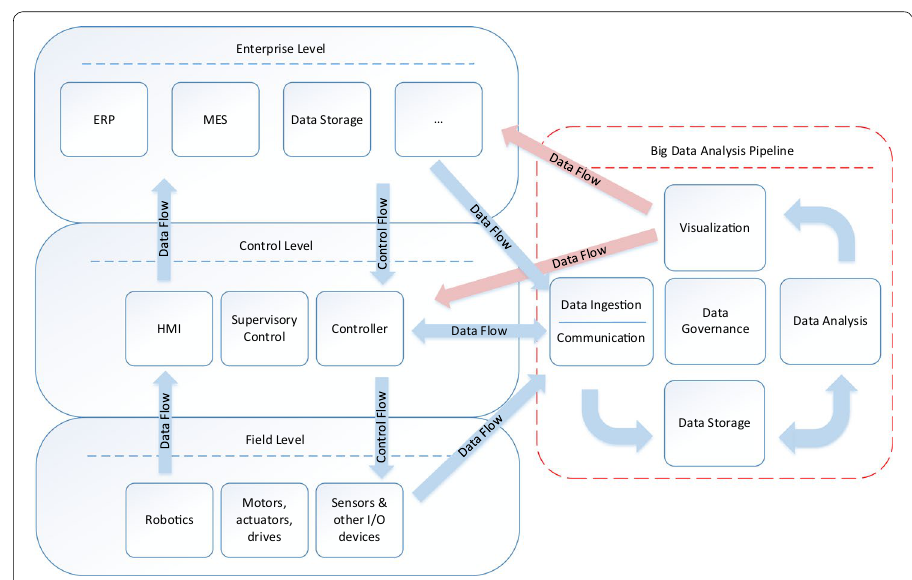
Fig. 5 Control and data flow between the manufacturing layers and a big data analysis